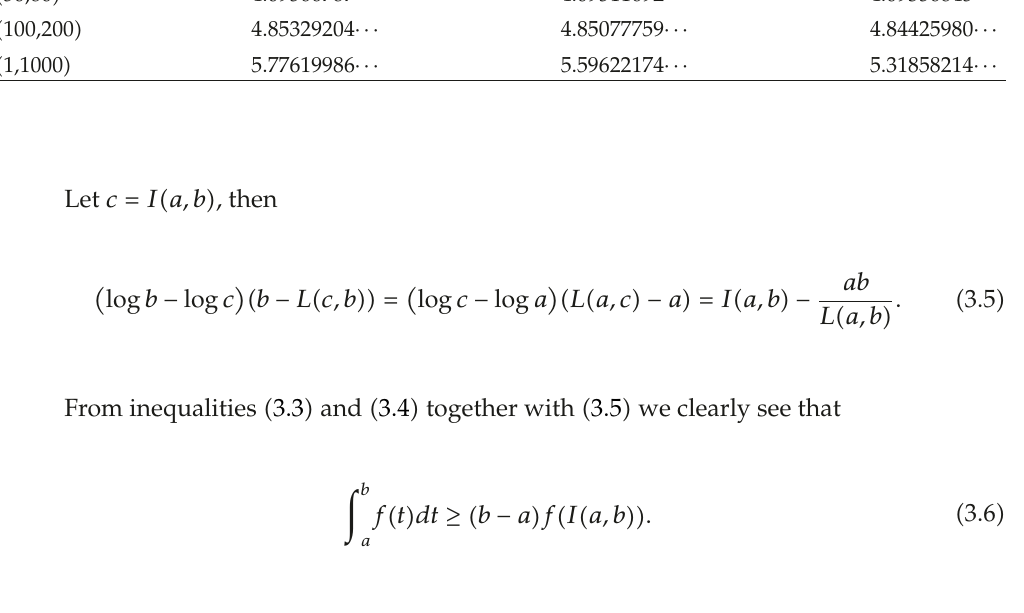
(cid:2) a,b (cid:3) with N 3